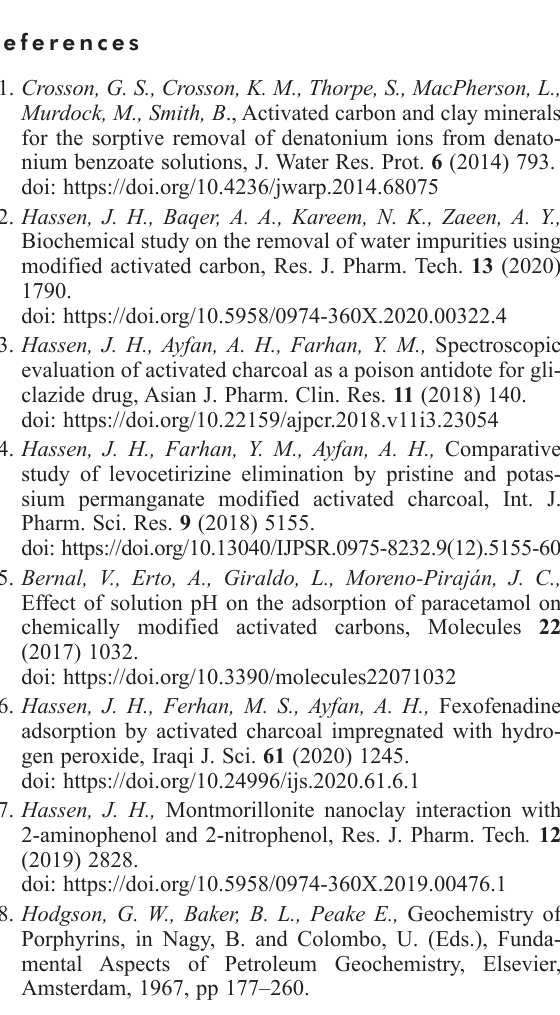
Fig. 6 – Schematic presentation of the orientation of the naphthalene groups in the MMT